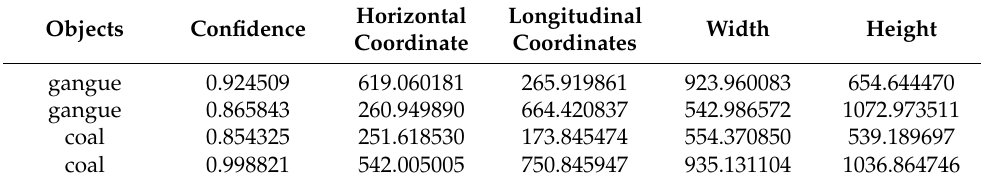
Table 3. Comparison of sorting rate under motion planning. Number of Objects